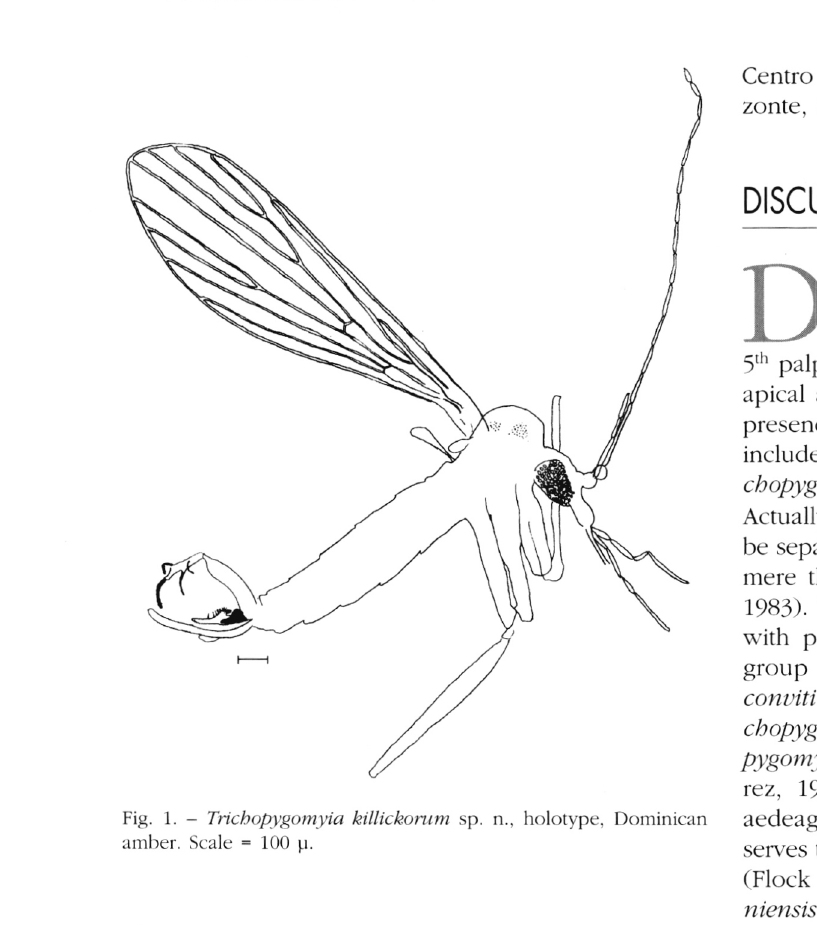
Thorax: thoracic bristles not visible except for those seen on the notum. Wings with 1,585 in length and 465 width. Principal wing indices: a (R2) - 306; P (R2 + R3) - 204; γ (R2 + R3 + R4) - 272; 5 (part of R1 that extends beyond the junction of R2 + R3) - 45. Legs without special characters. Anterior, median and pos­ terior femorae measuring 600, 657 and 623, respecti­ vely. Anterior, median and posterior tibiae measuring 838, 1,076, 1,167. Anterior, median and posterior tar- someres measuring 521, 611 and 702